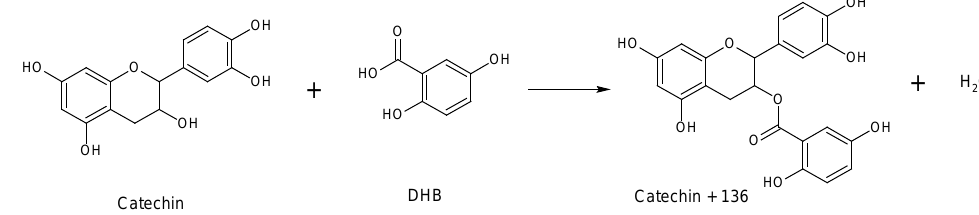
Figure 4. Esterification of catechin with the matrix molecule (DHB: 2,5 dihydroxybenzoic) during the MALDI-TOF experiment.